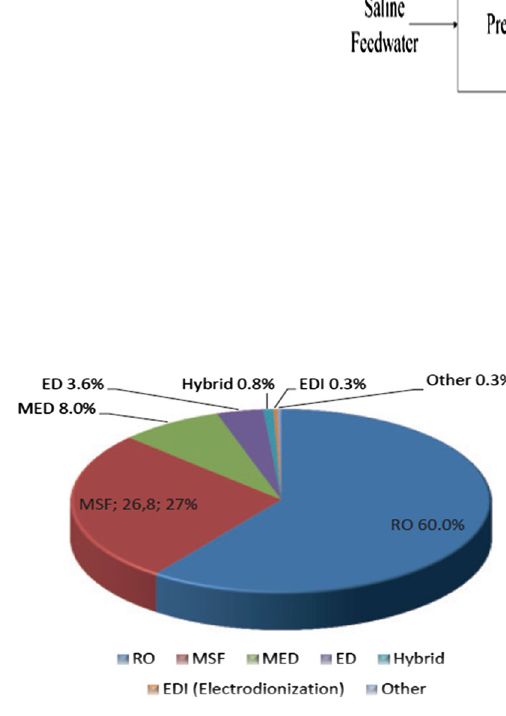
Fig. 3 Basic components of a reverse osmosis plant